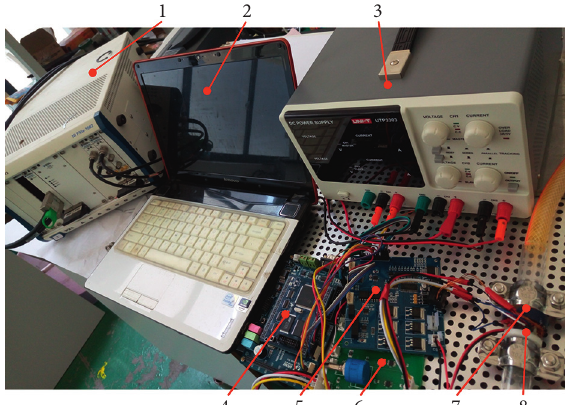
Figure 17: Experimental setup for measuring the axial displacement of the rotor: (1) DAQ system; (2)computer for data processing; (3) power supply; (4) DSP with the main controller chip STM32F103; (5) drive circuit for the brushless direct current motor; (6) low-pass filter; (7) prototype; (8) hall sensors.